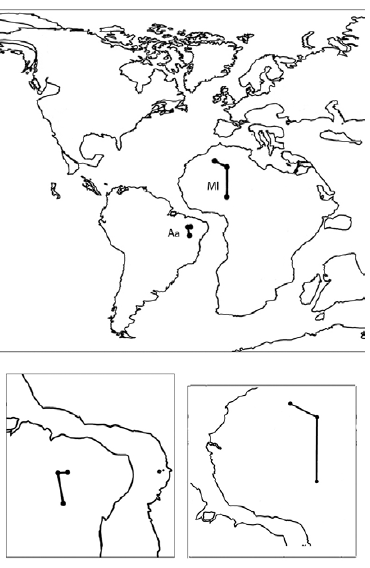
Fig. 10 - Albian paleogeographic map showing individual tracks of Axelrodichthys araripensis (Aa) and Mawsonia lavocati (Ml), with a zoom of the occurrences below.